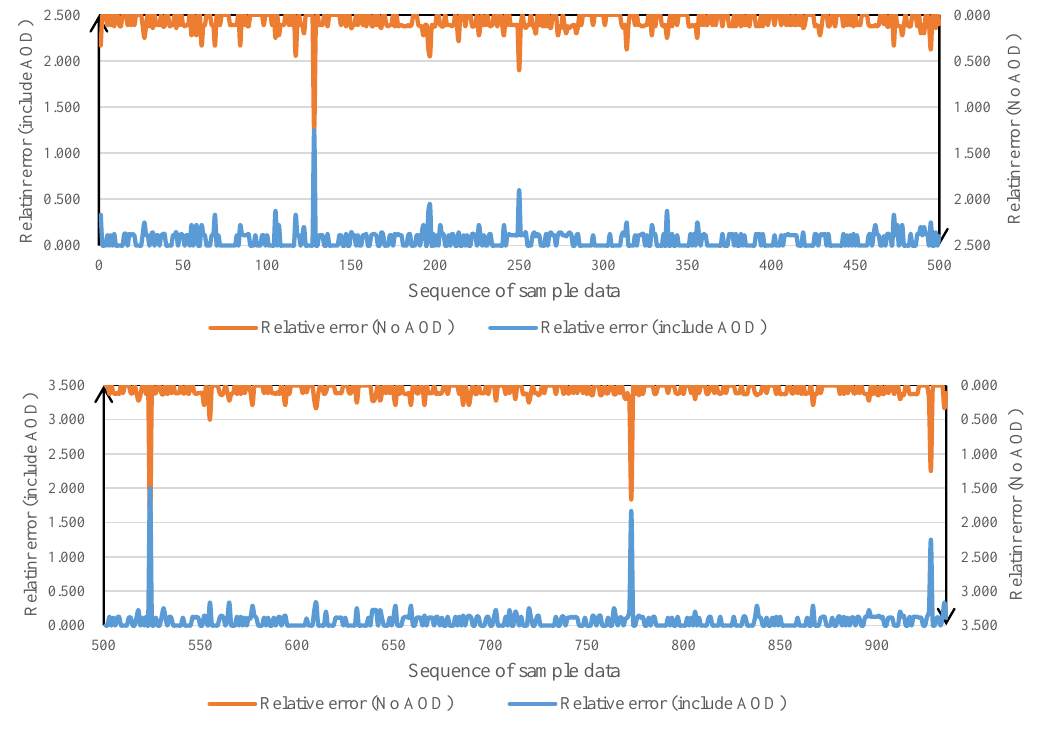
Figure 5. Composition of the average relative error of each observation point when taking AOD into consideration or not.